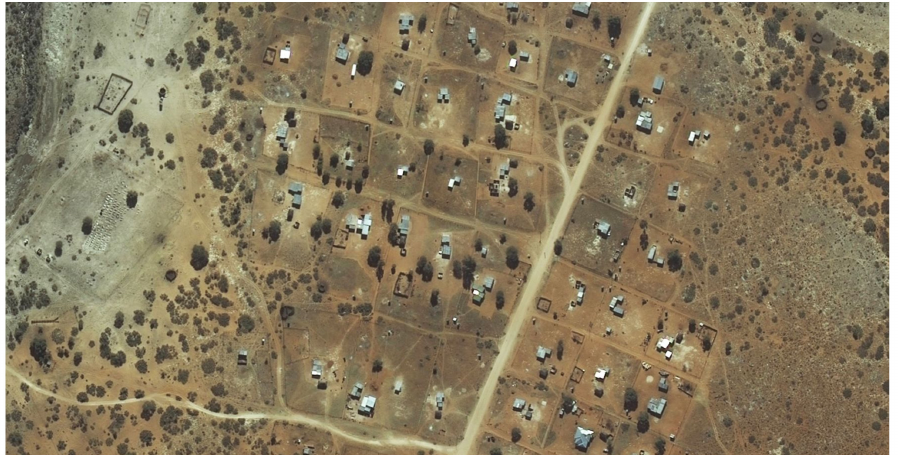
Figure 11. Extract from 2019 rectified imagery [12] (Ref: 2723 AB 7), showing an informal settlement known as Molomowapitsana, in the Northern Cape Province, at scale: 1:5000